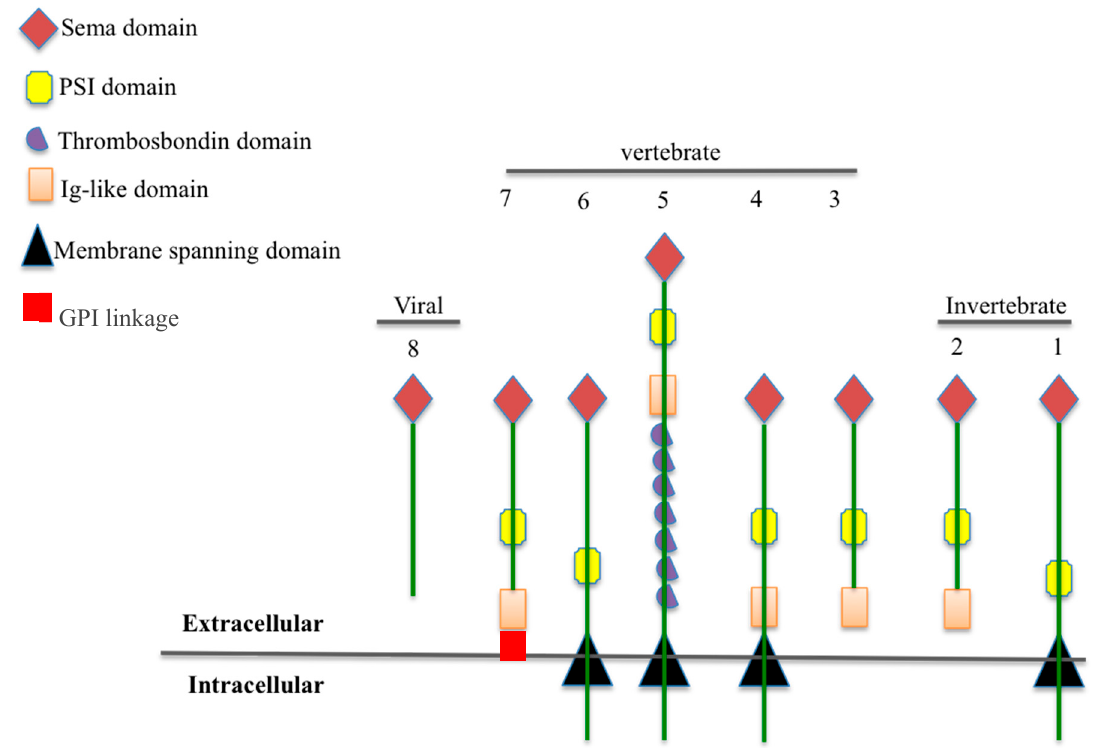
Figure 1. Classes and structures of semaphorins. Semaphorins are represented in their classification into eighth classes. Class 1 and 2 semaphorins are found in invertebrates. Class 3–7 semaphorins are found in vertebrates. The Sema domains characterize both semaphorins and plexins. Additional domains present in semaphorins and plexins include PSI domains (plexin, semaphorin, and integrin) and immunoglobulin (Ig)-like domains. Class 7 semaphorin (Sema-7) contains a membrane-associated GPI moiety at its carboxyl terminus. Class V (Sema-8) semaphorins are highly similar to the Class 7 semaphorins and are found in DNA viruses. Semaphorins can be either secreted or membrane-bound proteins. Note: Some members of the Class 4 semaphorins can be found in secreted form. Some members of the Class 3 proteins can be found on cell surfaces.